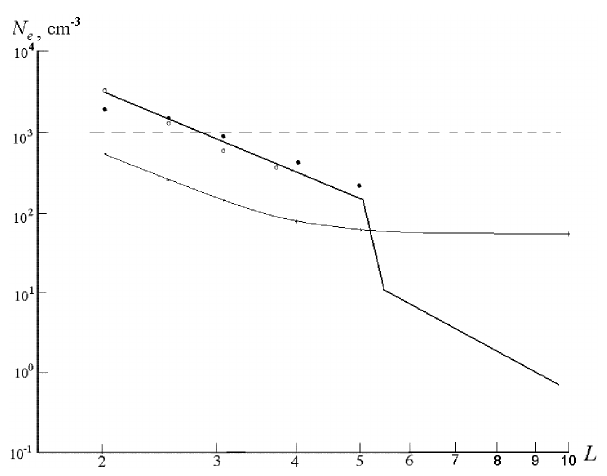
Figure 5. Averaged over the MLT the dependences N e (L) of a den- sity of an electron component of the cold plasma near the equa- torial plane for a quiet and weakly disturbed periods according to the model of Ozhogin et al. (2012) (thick broken curve), the model of Tarsai et al. (1988) (bright spots) and the model of Carpenter and Anderson (1992) (dark dots). Thin curve is N e (L) in Nakada and Mead (1965). The horizontal dotted line is N e (L) in Tver- skoy (1964, 1965, 1968, 1969). The plasmapause (the midpoint of the steep decline of N e ) on the thick broken curve corresponds to L = 5.2.